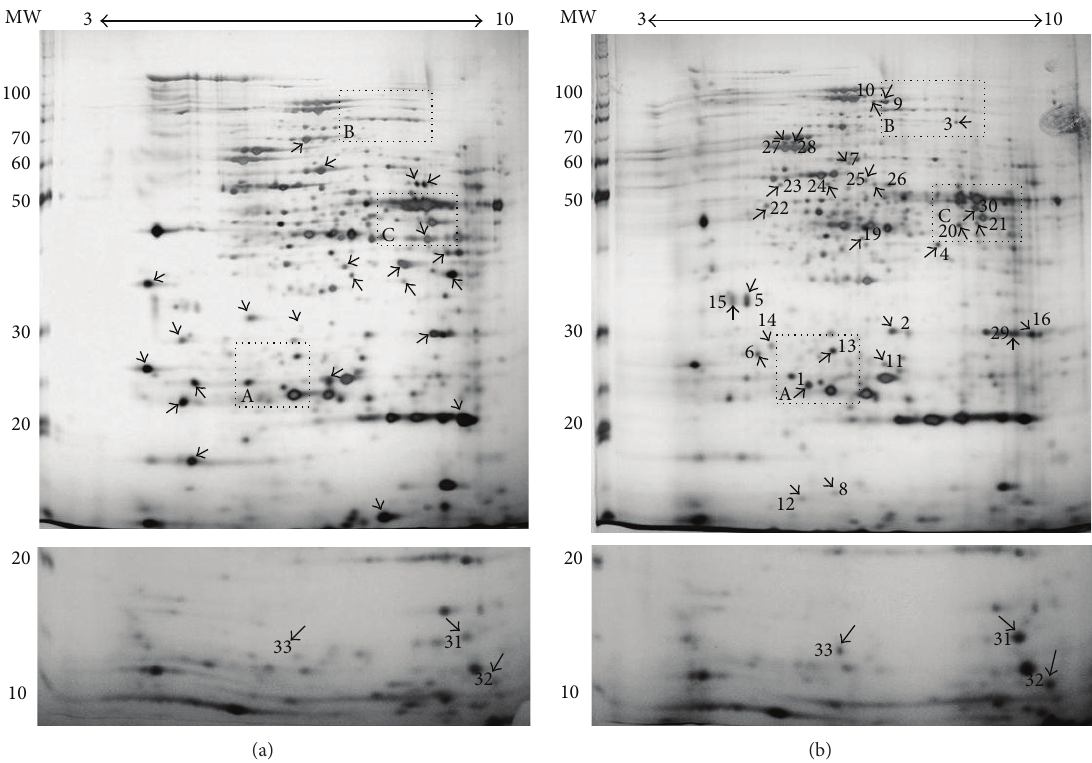
Figure 2: Changes in the proteome of S. metallicus grown in the presence of Cu. Cells were incubated in the absence of any added metal (a) or in the presence of 100mM Cu (b). Arrows indicate the spots that were downregulated (a) or upregulated (b) in the presence of Cu. Numbers indicate the spots with increased intensity in cells treated with copper. The dashed boxes are shown as enlarged areas that include some proteins upregulated in the presence of Cu and Cd (Figure 3). The bottom panels show low molecular weight proteins upregulated in the presence of Cu separated by using a 15% polyacrylamide gel in the second